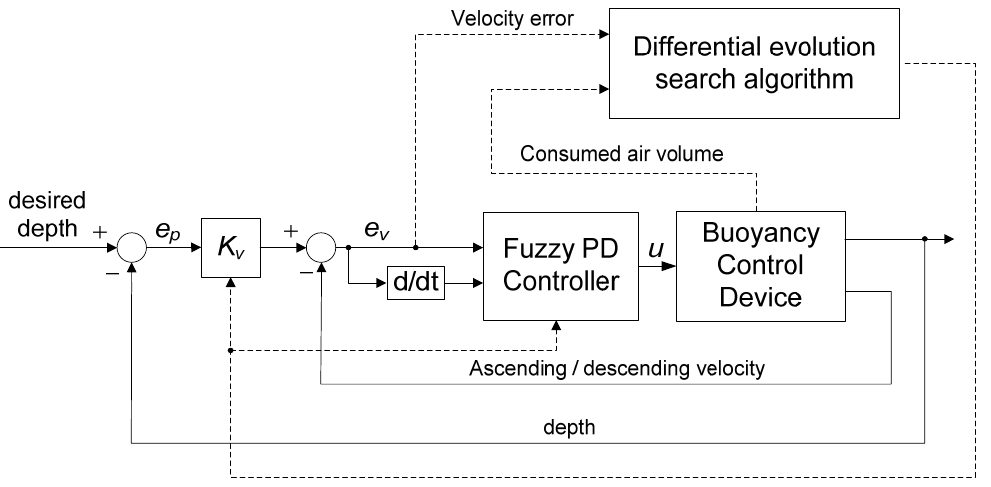
Figure 8. Velocity fuzzy PD control system setup for optimization ‐ aided design.